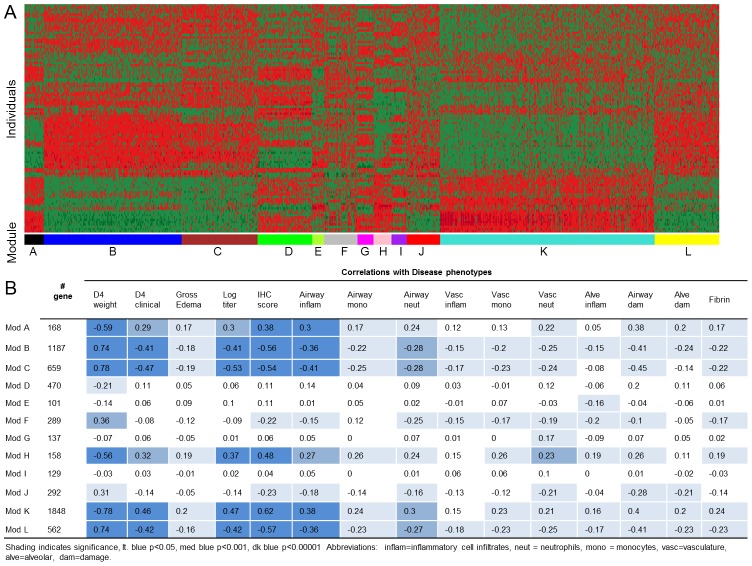
Transcriptional Modules across the pre-CC population.(A) highly variable transcripts from across the pre-CC population were grouped into modules (sets of transcripts that are connected and similarly expressed (shown here by heat map intensity) within individuals). Modules are given colored bars below them for visual clarity. (B) Modules were correlated with different disease phenotypes.